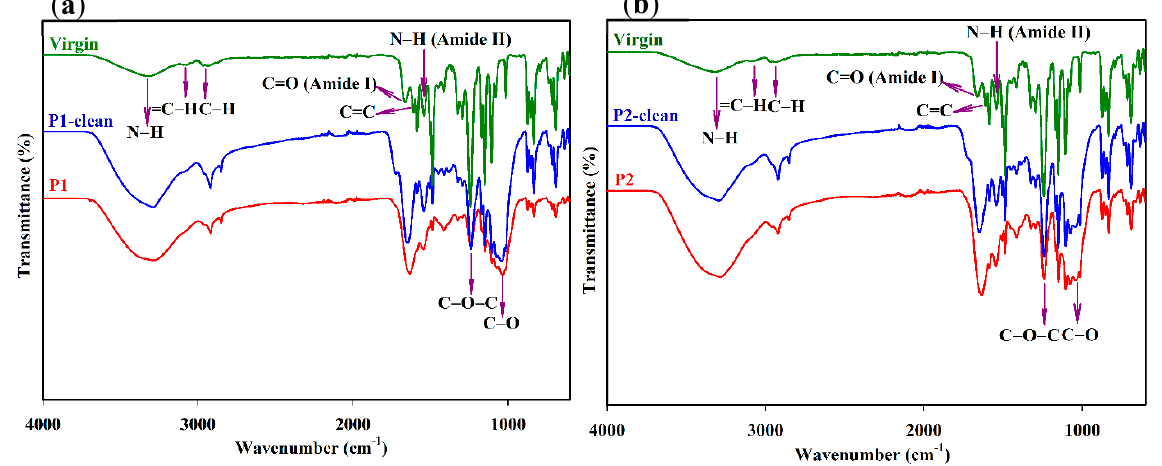
Figure 7. The FTIR spectra ( a , b ) of fouled membranes (P1 and P2) before and after cleaning with acid and base media and virgin membranes. Table 2. Peak assignments for FTIR spectra from the literature. Peaks Peak Assignments and